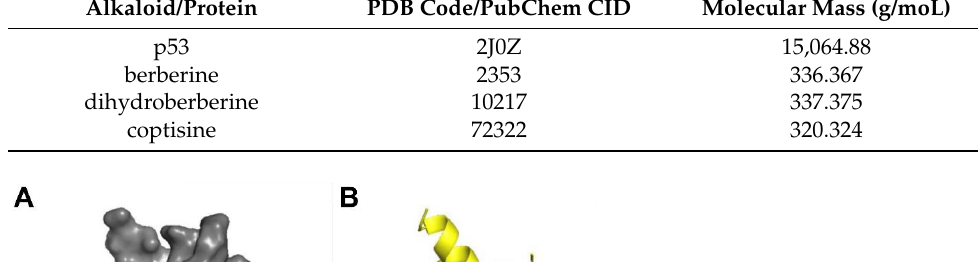
Table 4. p53 protein and alkaloids selected for ligand–protein molecular docking.